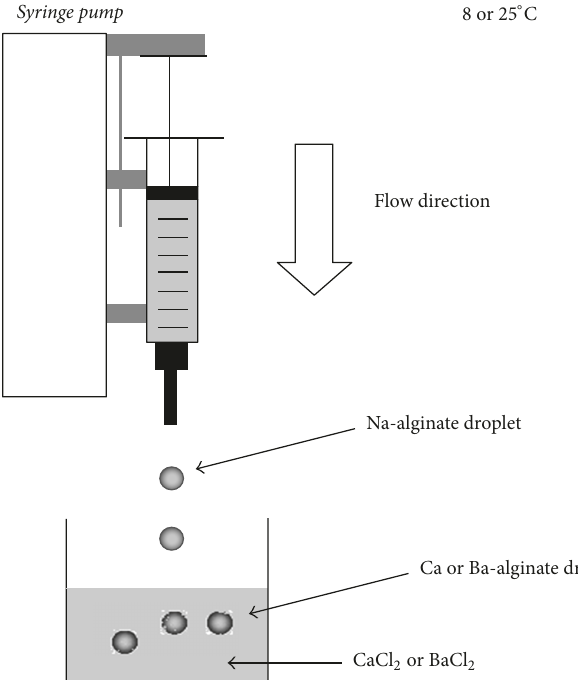
Figure 1: Schematic drawing of alginate bead